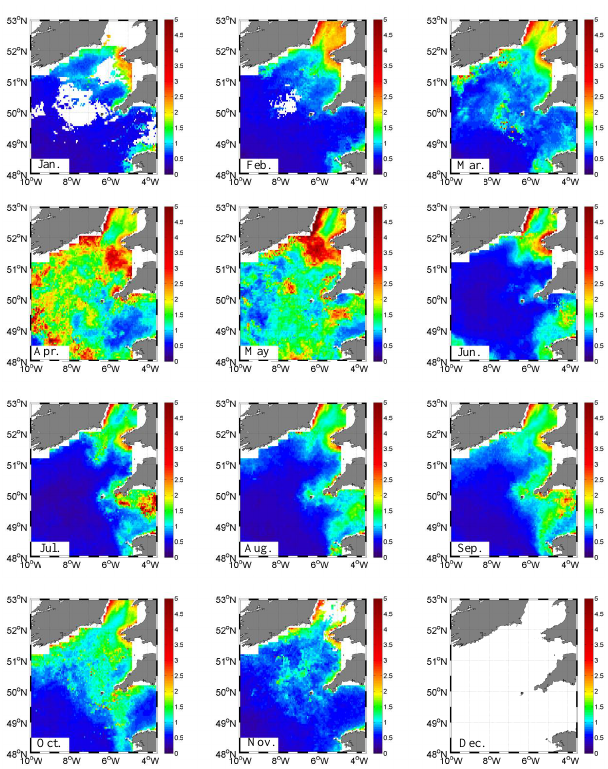
Figure 9. Monthly satellite Chl a (µgL − 1 ) averaged from 2003 to 2013 from January (top left corner) to December (bottom right cor- ner). Satellite Chl a data were not available in